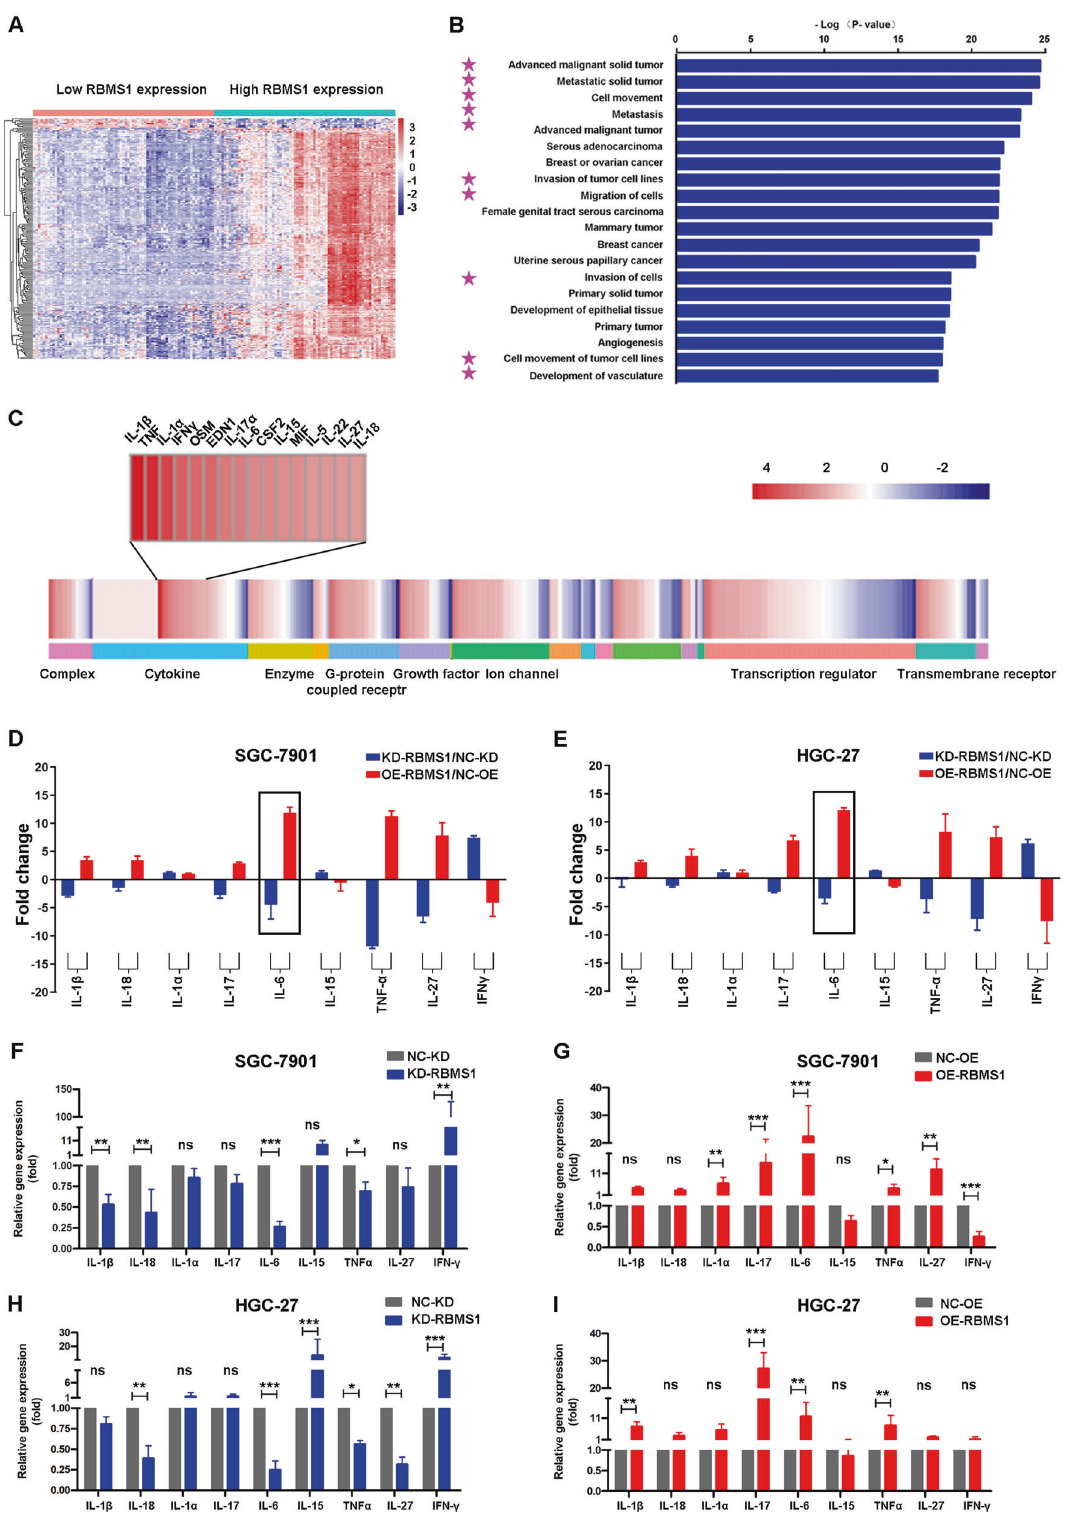
Fig. 6 IPA analysis of potential RBMS1 regulatory mechanisms. A Heatmap showed the RBMS1-related differentially expressed genes using IPA software. B Top 20 affected disease functions based on IPA. The horizontal bars denote the different pathways based on the log ( P value). Pink stars indicate the metastasis-related functions of cancer. C Hierarchical clustering of the DEGs (fold change = 2.0; FDR P < 0.05). Each column represents a sample, and each row represents a transcript. The expression level of each gene in a single sample is depicted according to the color scale. D , E The concentrations of cytokines in culture supernatants of HGC-27 and SGC-7901 cells were measured by Luminex assays after knockdown or overexpression of RBMS1. F – I The mRNA levels of cytokines were detected by qPCR in the RBMS1-KD and RBMS1- OE GC cell lines. NC negative control, OE overexpression, KD knockdown. NS not signi fi cant; * P < 0.05, ** P < 0.01, *** P < 0.001.